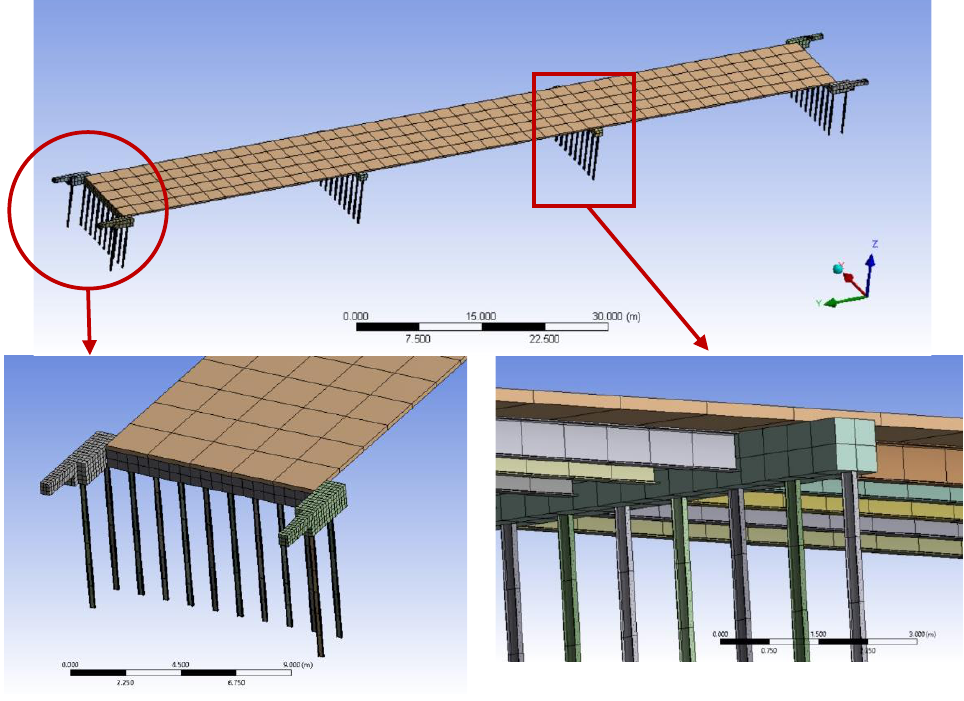
Figure 5. The final FE model of the integrated concrete bridge with steel piles based on the studies of mesh convergence.